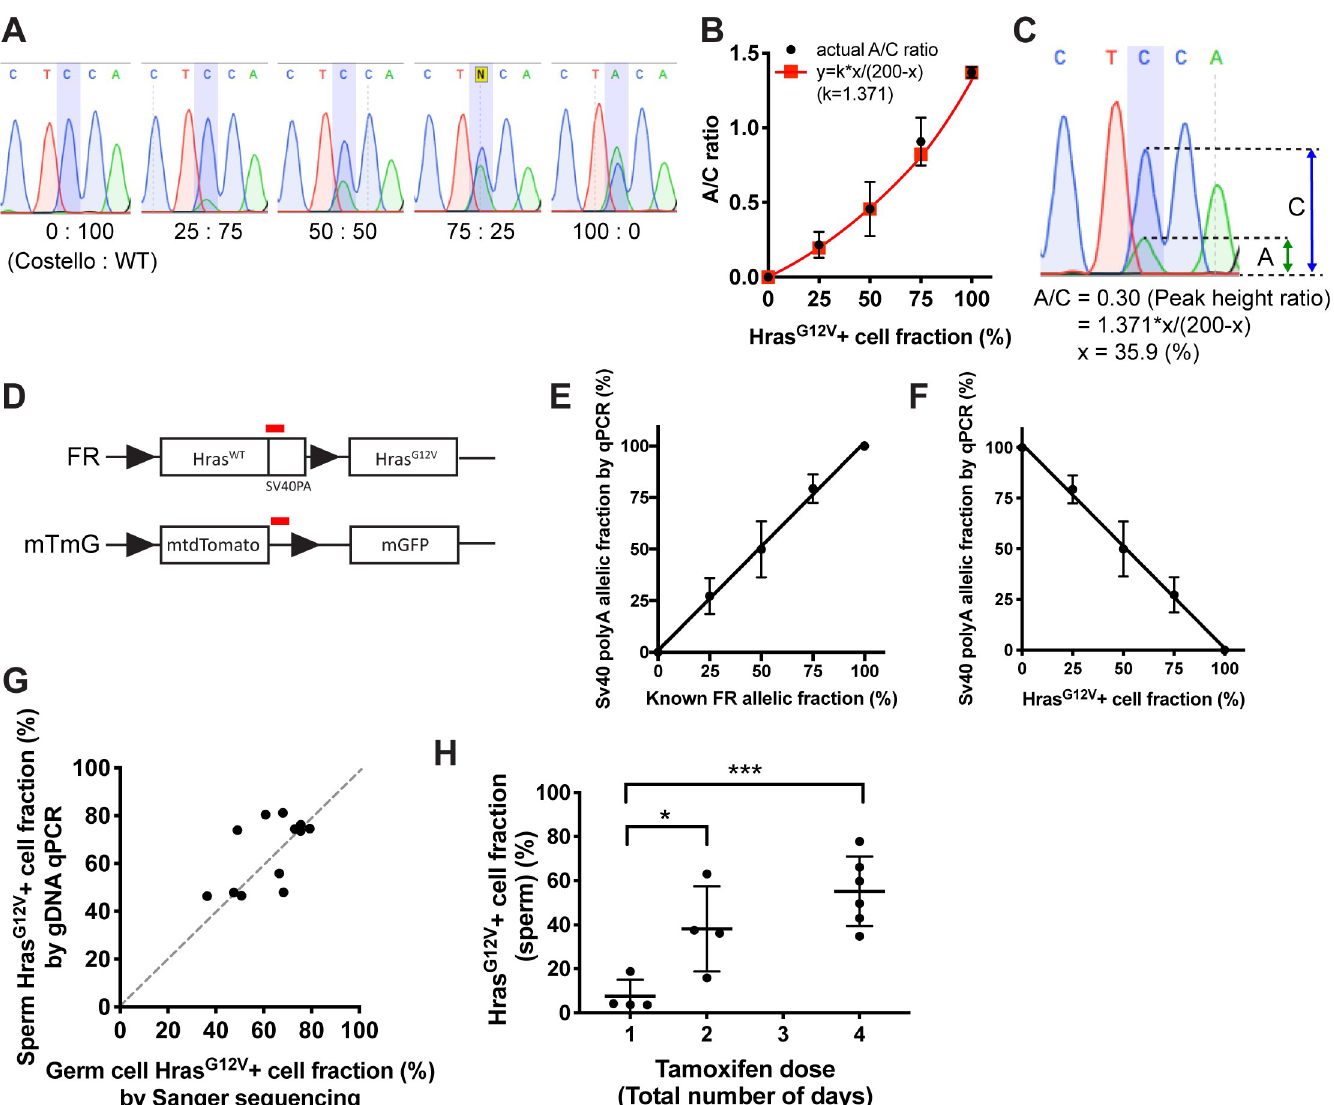
Fig 2. Quantification of Hras G12V fractional abundance. A. Five representative chromatograms from Sanger sequencing. Costello and WT offspring RNA were mixed at varying ratios (0–100%), reverse-transcribed into cDNA, amplified by PCR, and sequenced. N � 3 mouse pairs were used for each concentration. B. Generation of a model curve for quantification of variant nucleotide. To quantify the mutated nucleotide (cytosine ! adenine) from Sanger sequencing traces, a model curve (See S1 Fig) was proposed as y = k � x/(200-x) in which x is Hras G12+ cell fraction, y is A/C ratio, and k is a constant for PCR efficiency difference between WT and Hras G12V templates. By using the actual A/C ratios obtained by Fig 1A, we confirmed k = 1.371. C. An example of calculation for the Hras G12V + cell fraction: x %. Peak heights of A and C were measured by image analysis (ImageJ) and A/C = 0.30 was obtained. Using the equation: y = 1 . 371 � x/(200-x) , x = 35.9 (%) was obtained. D. Quantification of Hras G12V + cell fraction using gDNA. gDNA qPCR primers were designed to amplify the red regions of SV40 polyA and the end of mtdTomato alleles respectively. Tamoxifen-inducible Cre-mediated recombination results in deletion of these regions. E. By running qPCR with mixed sperm gDNA of FR heterozygote (without recombination) and wild-type sperm at varying ratios (x-axis: 0, 25, 50, 75, 100%: n = 3 samples per each), we confirmed the linear relationship between the known FR allele+ cell fraction ( x %) and SV40 polyA allelic fraction ( y %) obtained by qPCR ( y = x ). F. Loss of SV40 PA implies a gain of Hras G12V , indicating that the SV40 PA allelic fraction (y%) is in inverse proportion to the Hras G12V -positive cell fraction ( z ), ( y = 100-z ). G. Scatter plot showing the correlation between the germ cell Hras G12V -positive cell fraction by Sanger sequencing and the sperm Hras G12V -positive cell fraction by gDNA qPCR. Each dot represents one animal (n = 12). A significant correlation was observed (R 2 = 0.349, P [two-tailed] = 0.0437). H. Tamoxifen dose-dependent increase in Hras G12V -positive cell fraction. After 3 months from tamoxifen administration, sperm from the cauda epididymis was sampled, and the Hras G12V -positive cell fraction was calculated by gDNA qPCR. Tamoxifen (100mg/kg) was administered either one, two, or 4 days, consecutively (n � 4 mice per dose). The Hras G12V -positive cell fraction increases as the dose (number of days) increases. T-test was performed to compare the two doses ( � P < 0.05, ��� P < 0.001).